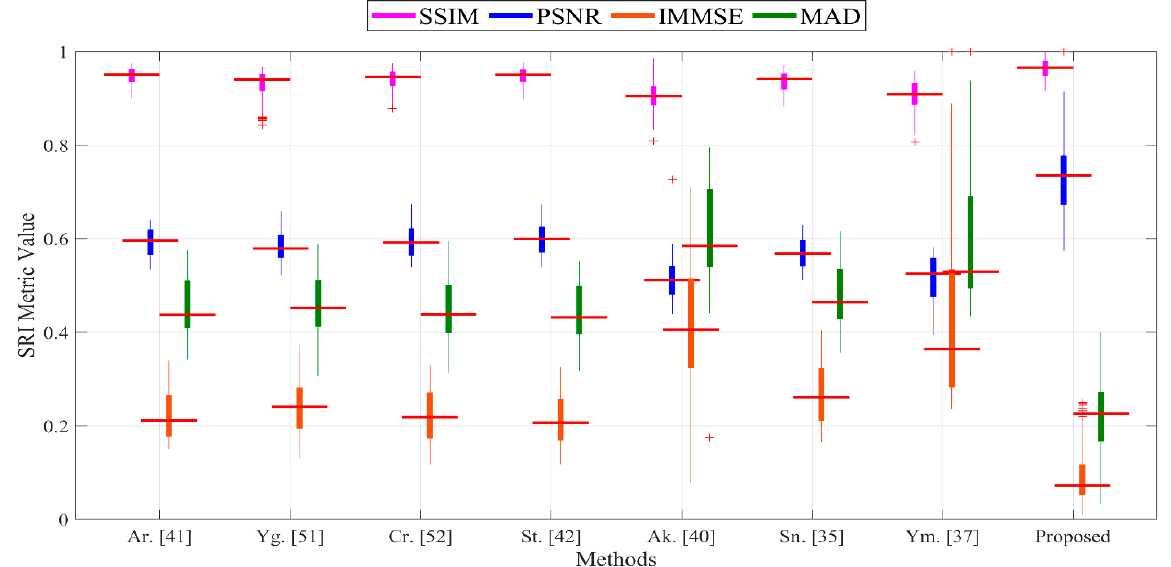
Figure 17. Evaluation results for SRI performances of different methods for 121 sub-aperture + 1 maiden images × 18 objects = 2196 images in terms of SSIM, PSNR, IMMSE, and MAD.